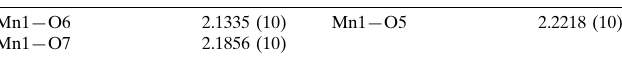
Selected bond lengths (A˚ ).